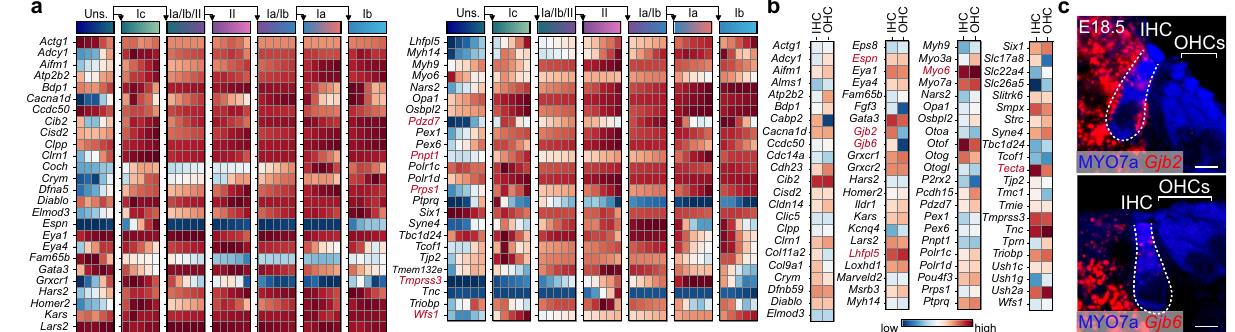
Fig. 6 Expression of deafness genes in developing SGNs and HCs. a , b Heatmap of deafness genes related to hereditary hearing loss present in our dataset within SGN lineage trajectory ( a ) as in Fig. 2a and in HC clusters ( b ) from Fig. 5b. Genes referenced through the text are highlighted in red. c In situ con fi rmation of Gjb2 and Gjb6 expression in both supporting cells and IHCs (MYO7a + ) at E18.5, using RNAscope. Data in a represent max normalized fi tted gene expression. Scale bar: 10 µ